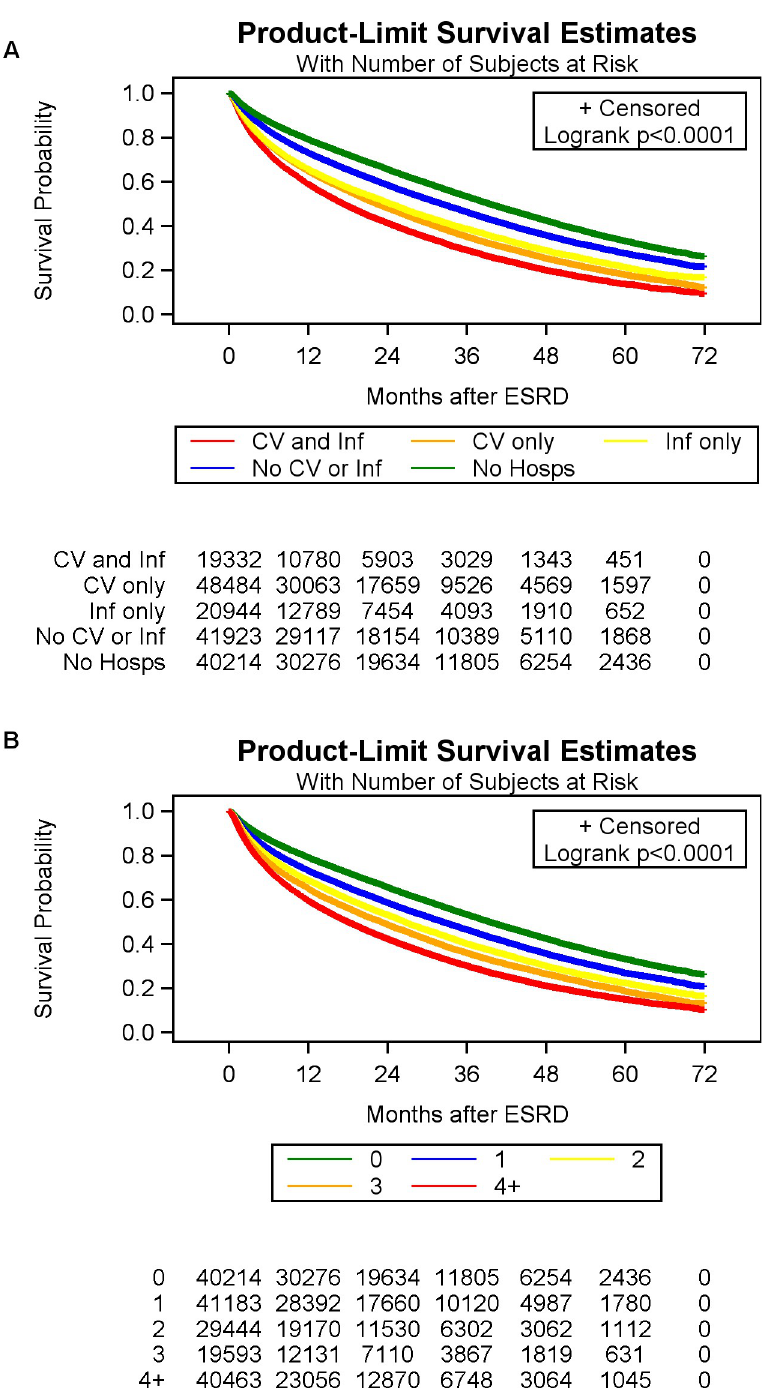
Fig 3. Unadjusted Kaplan-Meier survival curves for patients with and without pre-dialysis acute hospitalization censored on 31 December 2015 by (A) type of pre-dialysis hospitalization, and (B) frequency of pre-dialysis